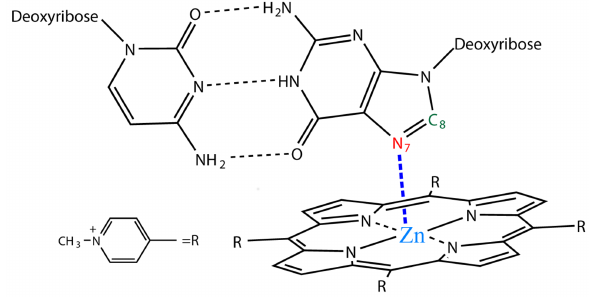
Scheme 1. Schematic diagram for the central metal zinc(II) of ZnTMPyP4 coordinating with guanine N 7 of